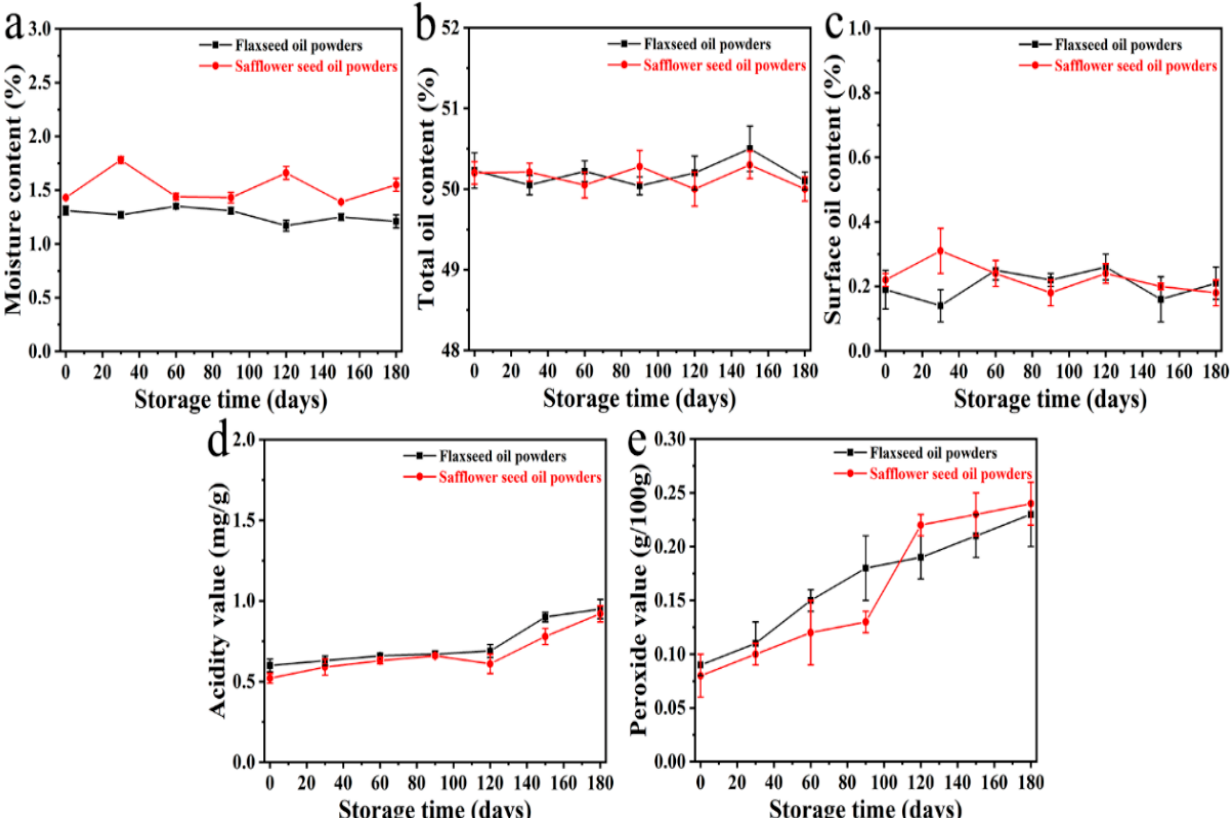
Figure 4. Moisture contents ( a ), total oil contents ( b ), surface oil contents ( c ), acidity values ( d ), and peroxide values ( e ) of the flaxseed oil powders and safflower seed oil powders over a storage period